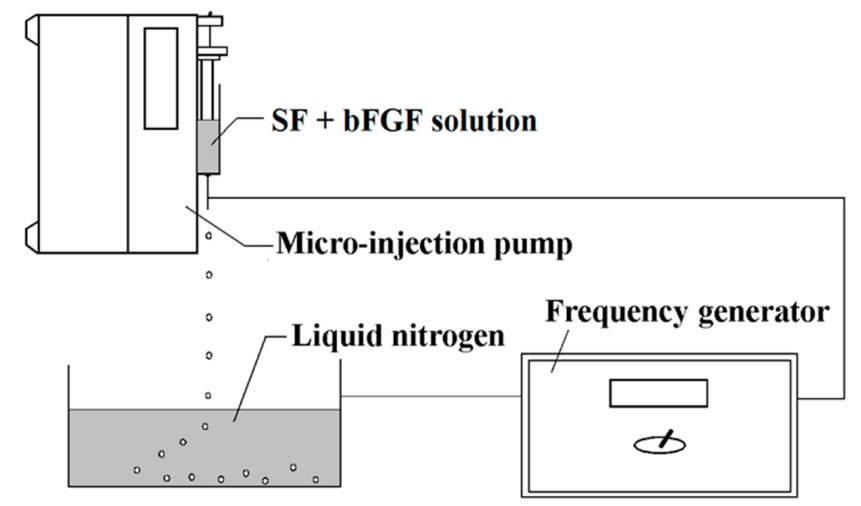
Figure 6. Illustration showing the experimental setup used for the preparation of SF